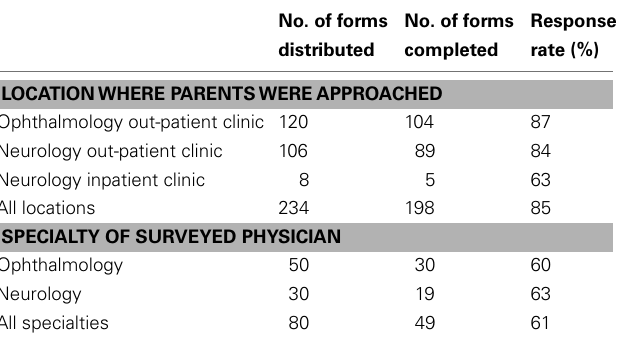
Table 1 | Baseline characteristics.